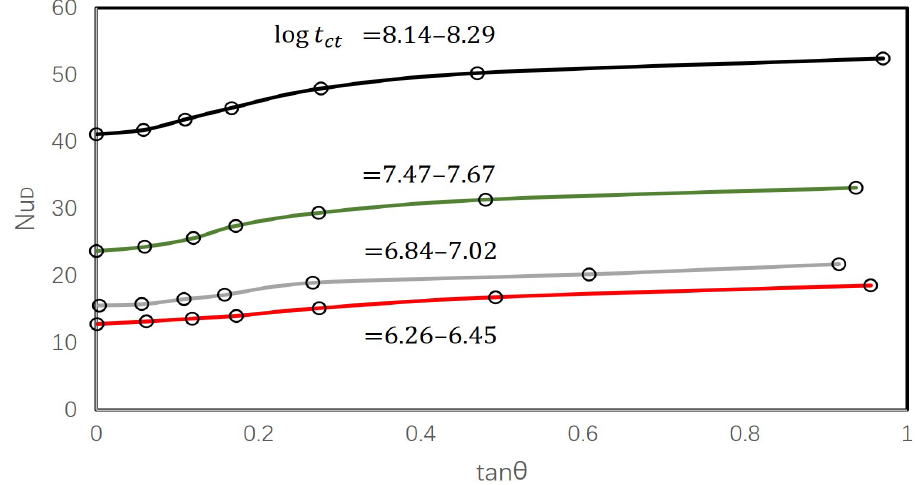
Figure 14. Heat transfer rates in an inclined closed thermosyphon with water (data from [54]; t ct = β gD 4 ∆ T / ν aL ) .